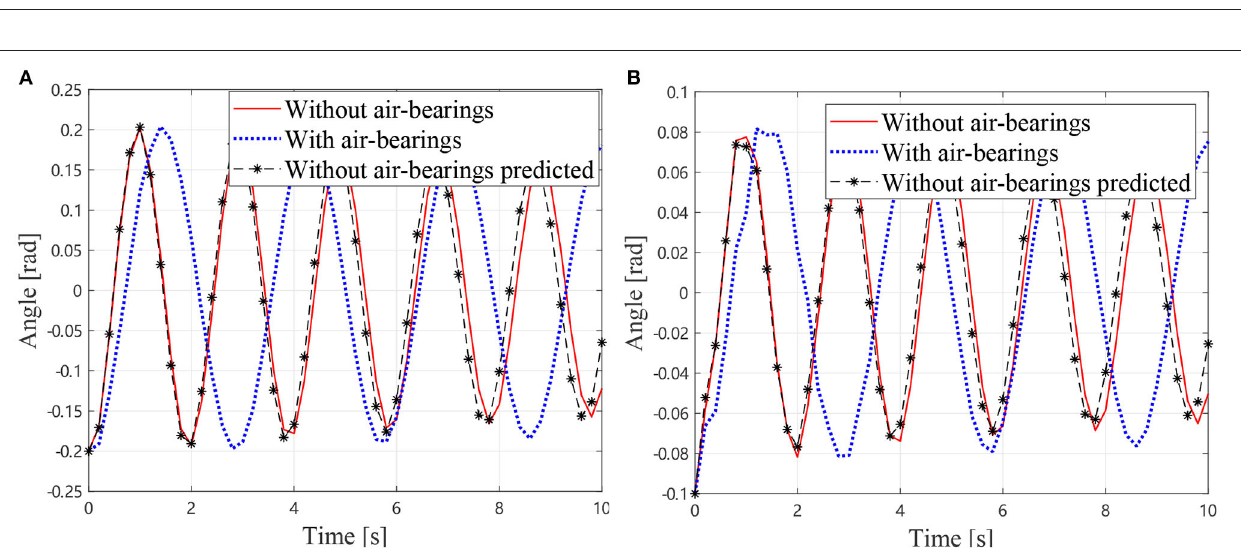
FIGURE 6 | Simulational vibration angles with air bearings, (A) Angles of J 1 (B) Angles of J 2 .